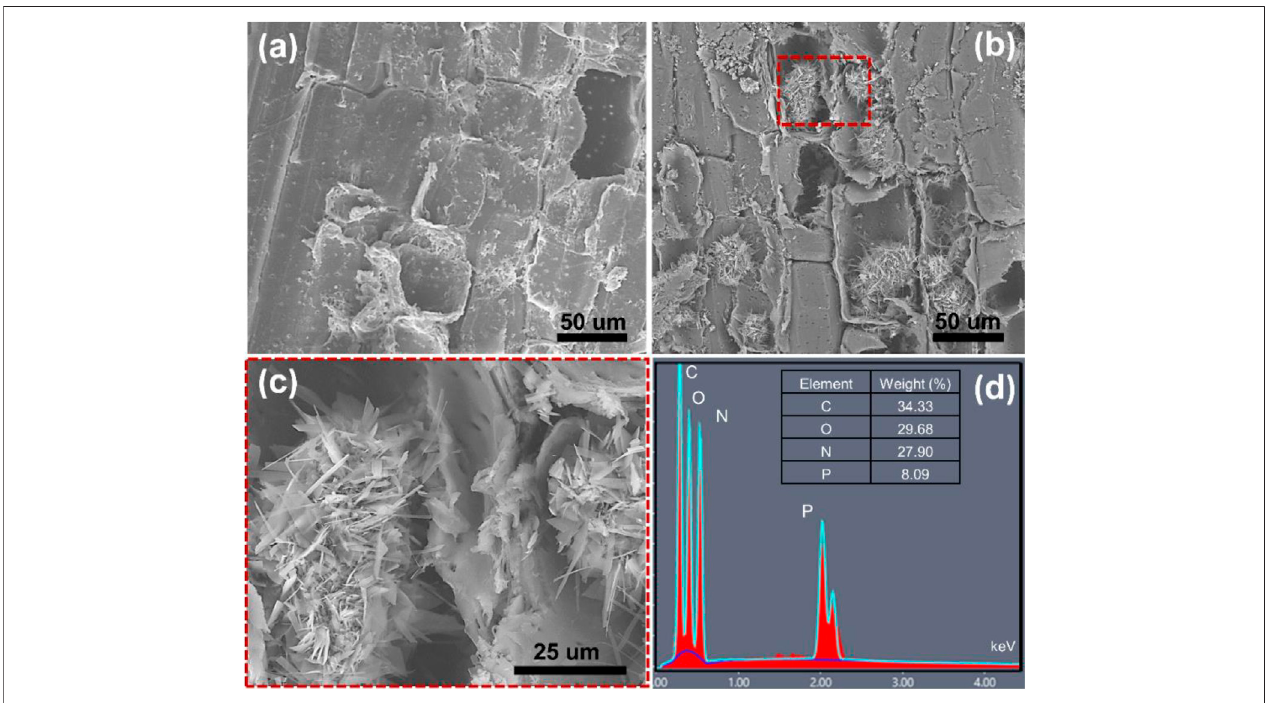
FIGURE 3 | SEM image of untreated bamboo (A) , treated bamboo after fi ve cycles (B, C) , and EDX patterns of treated bamboo (D) .